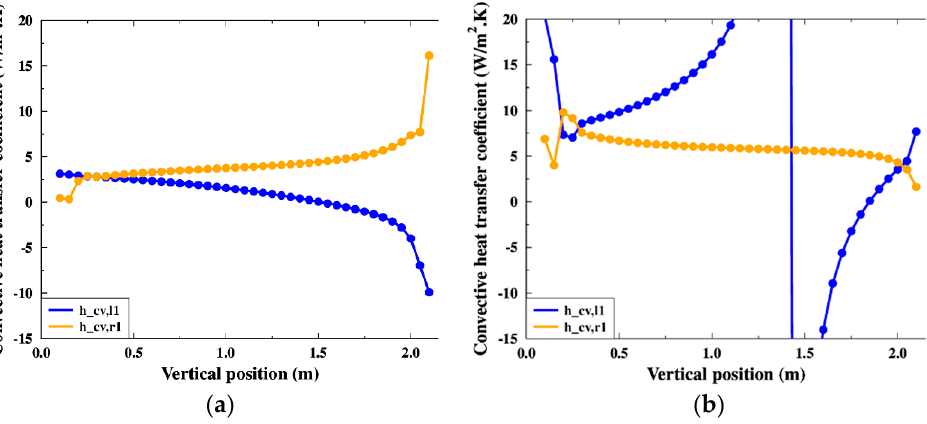
Figure 6. Local convective heat transfer coefficients in the ( a ) outer gap and ( b ) inner gap. The convective heat exchange between the air cavity surface and the air is defined as: